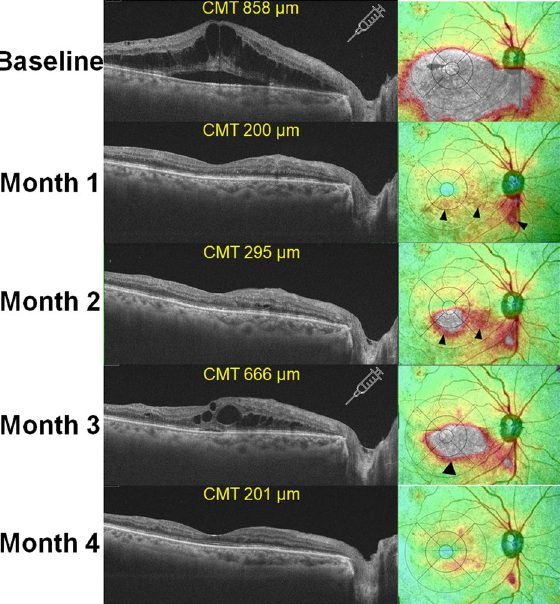
Figure 3. Optical coherence tomography B-scans and retinal thickness maps demonstrating the evolution of macular edema (ME) recurrence over time. At 1 month following initial anti-vascular endothelial growth factor (VEGF) therapy, residual edema remained in the peripapillary and para/perifoveal areas (arrowheads). At month 2, the residual edema in the macular areas was aggravated and expanded. Subsequently, the edematous areas further enlarged and merged into a larger area, leading to recurrence of ME (central macular thickness [CMT] > 300 μm). The syringe icons indicate the timing of anti-VEGF therapy for